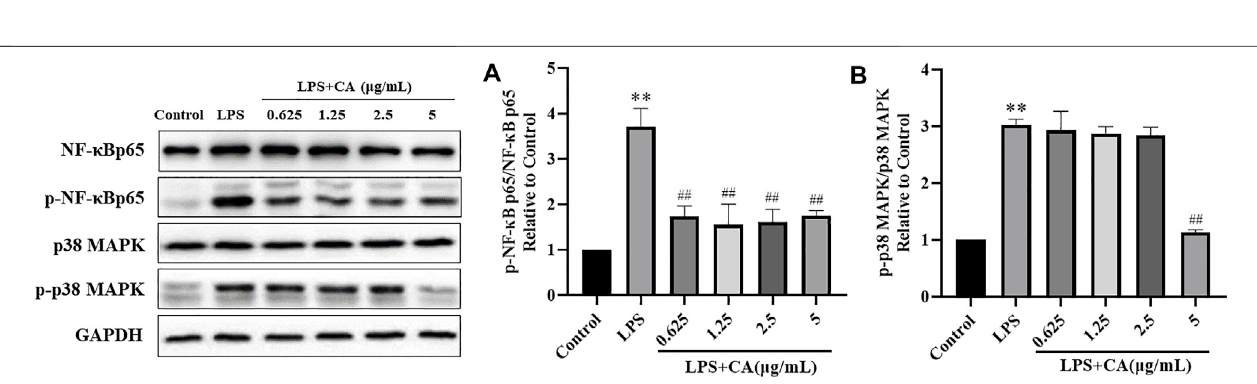
FIGURE9| Therelease ofNO (A) ,IL-1 β (B) ,IL-6 (C) ,TNF- α (D) inRAW264.7cells. Cellswerepretreated withorwithoutvariousconcentrationsofCAfor2 h,and then co-incubated with or without LPS (1 μ g/ ml) for 24 h. The level of NO in cell culture supernatants was measured using Griess kit. The concentrations of IL-1 β , IL-6, and TNF- α in the cell culture medium were detected by ELISA kits. ** p < 0.01 vs . control group; # p < 0.05, ## p < 0.01 vs . LPS group.